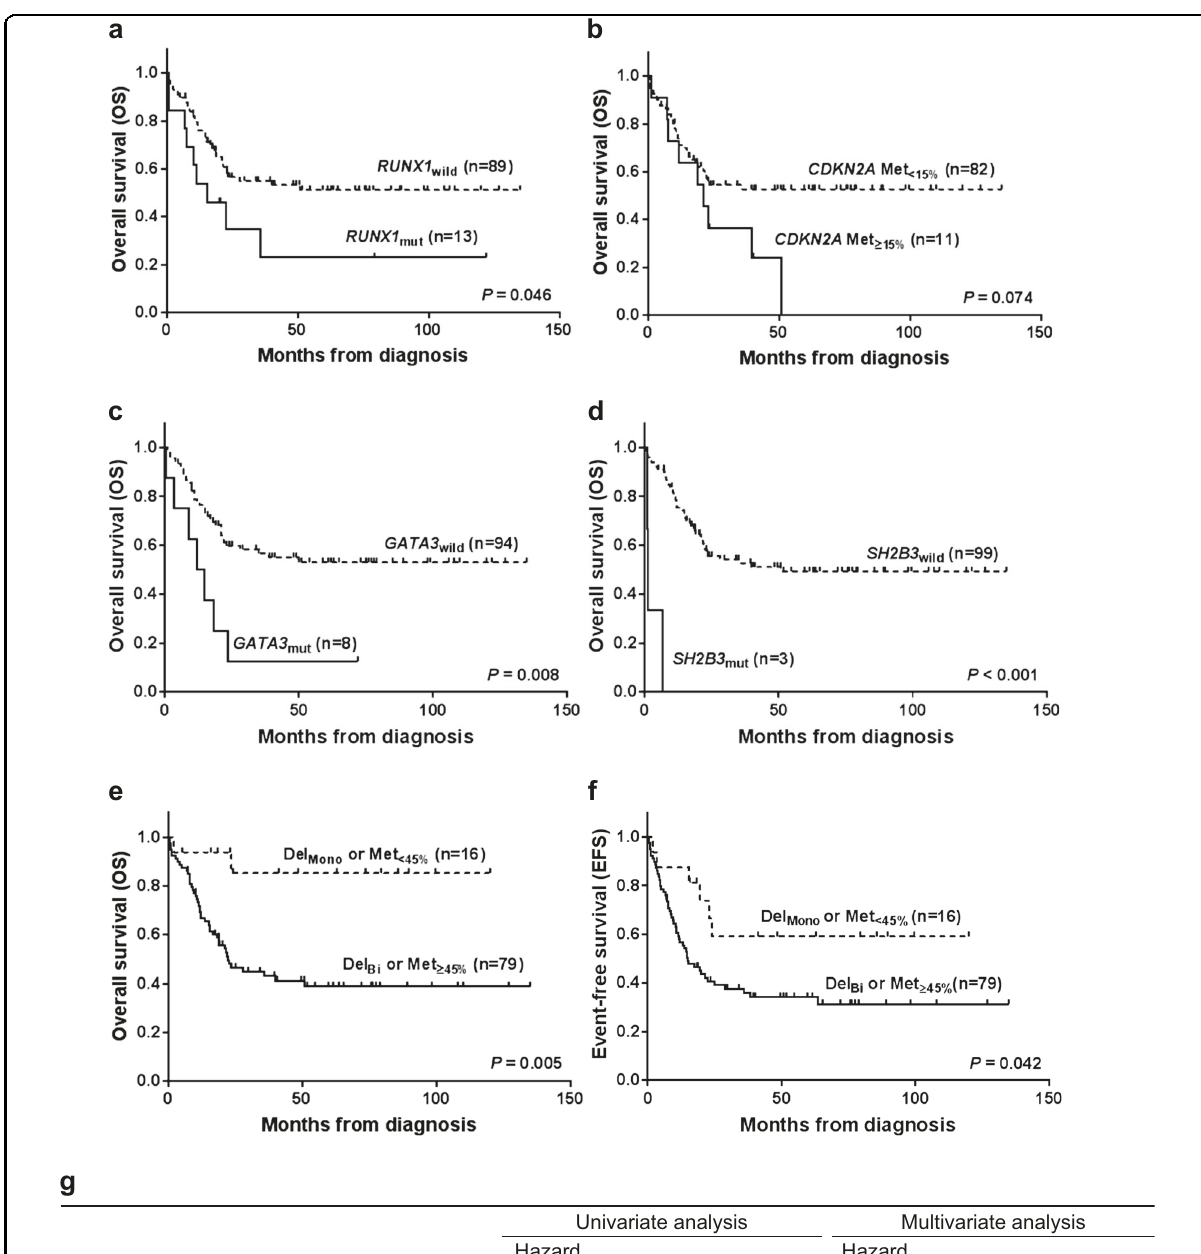
Fig. 4 Prognostic factors for T-ALL patients. RUNX1 mutation ( a ) and CDKN2A hypermethylation ( b ) were associated with reduced OS in T-ALL patients. Met <15% methylation level <15%, Met ≥ 15% methylation level ≥ 15%. GATA3 ( c ) and SH2B3 ( d ) mutations were independent markers of a poor prognosis for the OS in T-ALL patients. Kaplan – Meier analyses for OS ( e ) and EFS ( f ) for patients with T-ALL according to CDKN2B status (deletion and methylation). Del Mono monoallelic deletion, Del Bi biallelic deletion, Met <45% methylation level <45%, Met ≥ 45% methylation level ≥ 45%. g Univariate and multivariate analyses of factors associated with overall survival in T-ALL